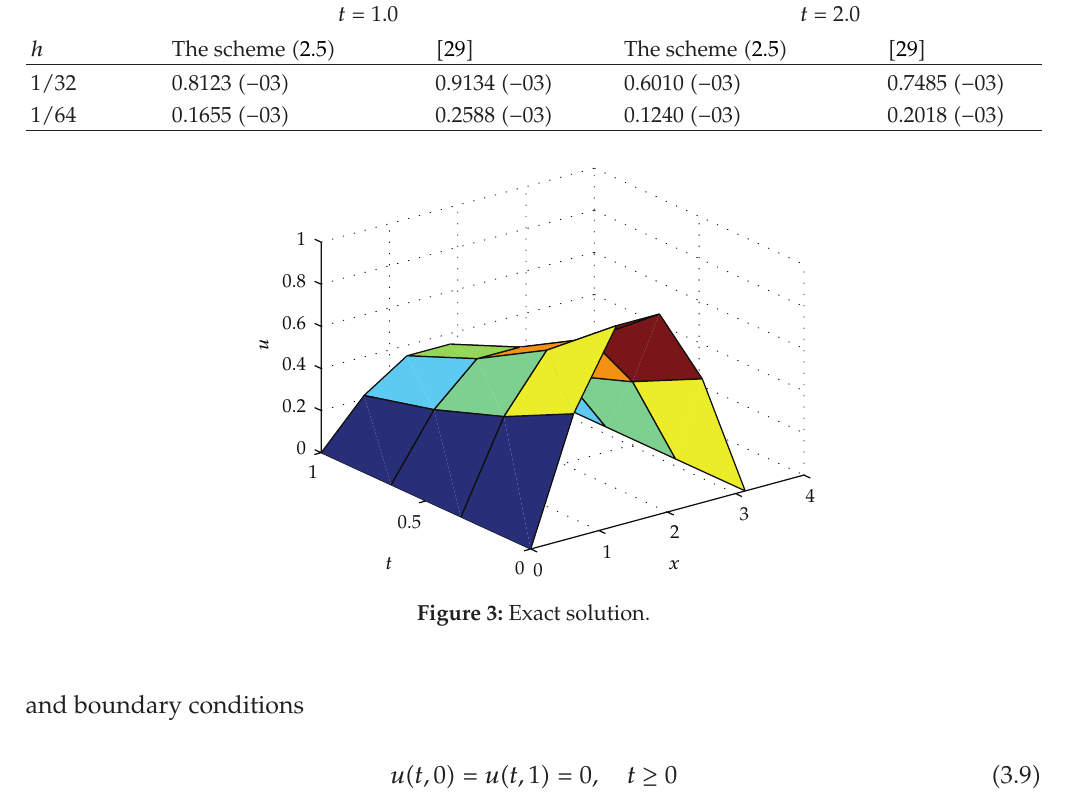
Table 2: RMS errors of scheme (cid:3) 2.5 (cid:4) and the scheme in (cid:6) 29 (cid:7) for α (cid:9) 40, β (cid:9) 4 when λ (cid:9) 1 . 6.